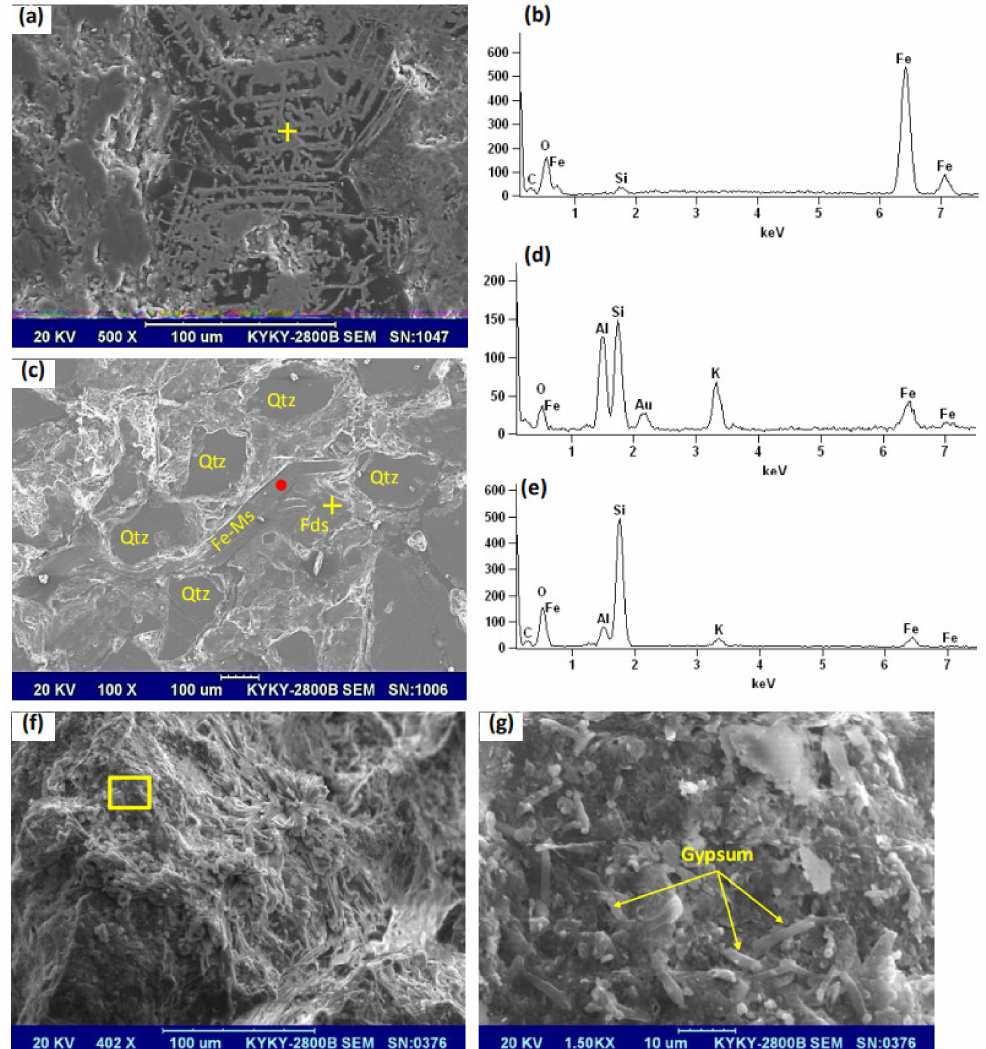
Figure 5. SEM images for studied sandstones: ( a ) needle-/network-like Fe(OH) 3 colloids; ( b ) EDS spectrum for the cross in ( a ); ( c ) quartz, feldspar (microcline), and muscovite grains cemented by colloidal Fe(OH) 3 ; ( d ) EDS spectrum for muscovite marked by the spot in ( b ); ( e ) EDS spectrum for feldspar (microcline) marked by a cross in ( b ); ( f ) daisy-like gypsum aggregates covering the surface of quartz grain; and ( g ) enlargement of rectangle in ( f ) showing the tabular gypsum single crystals. Abbreviations are same as in Figure 3. Gold and carbon shown in EDS spectra are due to the gold- and carbon-coating before SEM